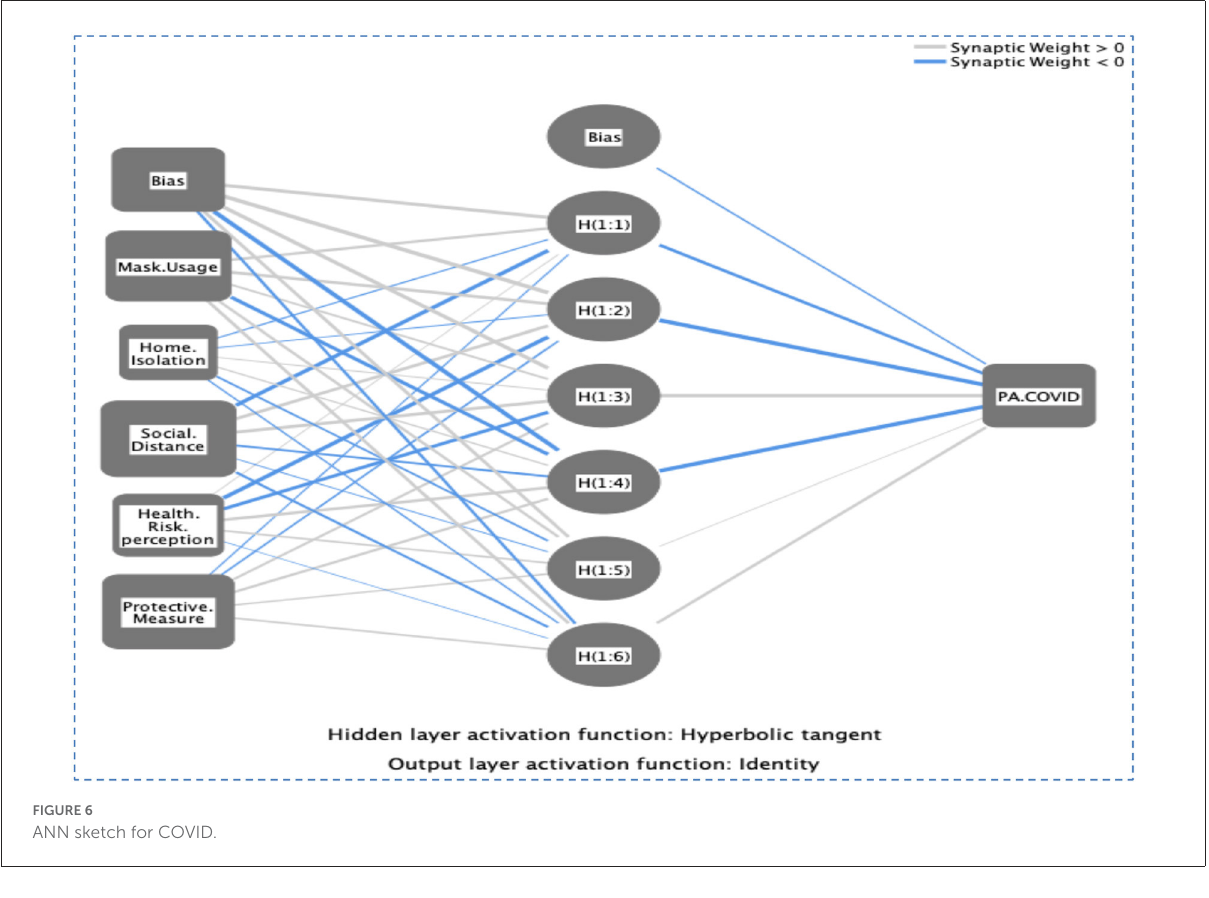
TABLE 7 RMSE values for training and